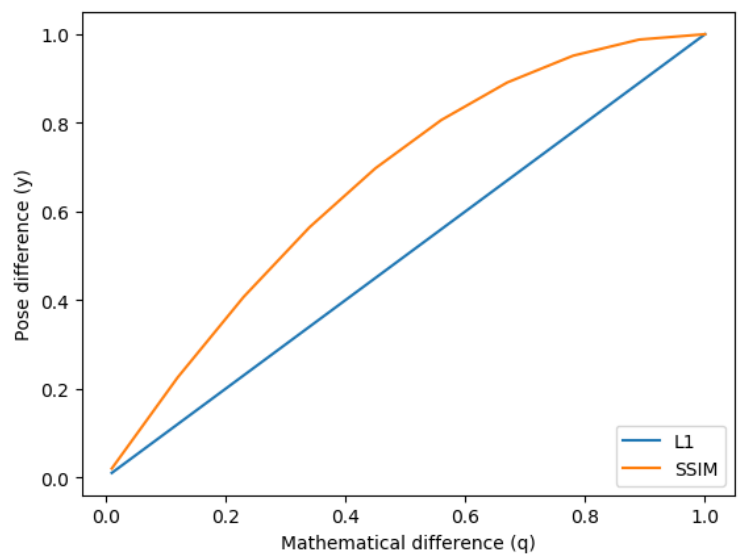
Figure 2. Under the same mathematical difference condition, comparing the pose difference of L1 loss, SSIM